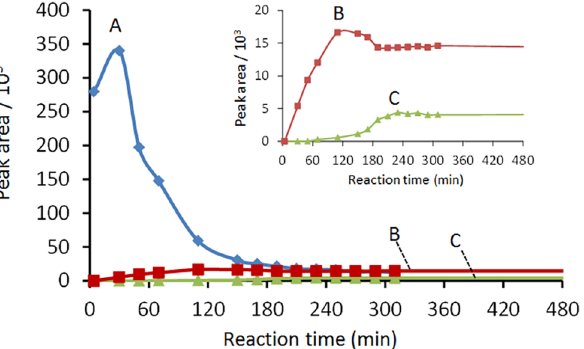
Fig 3. Peak area vs. reaction time curves for products A, B and C. Peak areas were obtained from HPLC-UV-DAD chromatograms (absorbance at 254